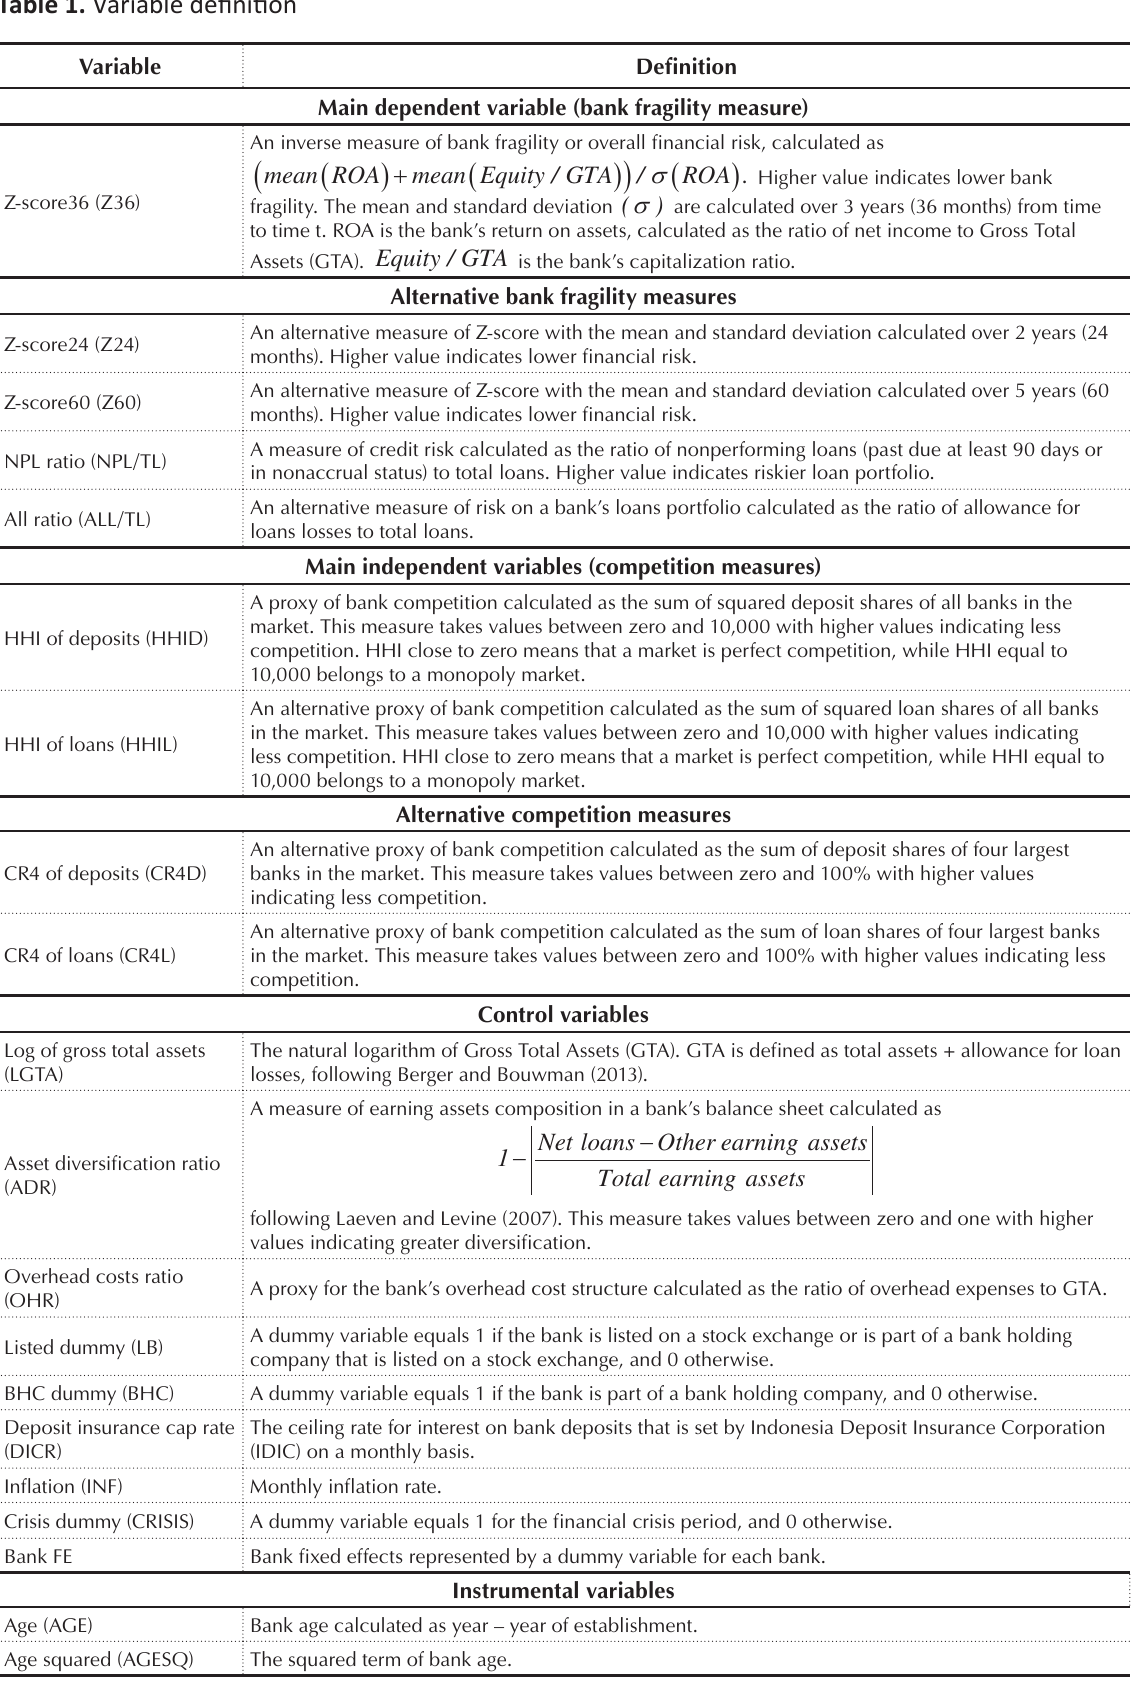
Table 1. (cid:115)(cid:258)(cid:396)(cid:349)(cid:258)(cid:271)(cid:367)(cid:286)(cid:3)(cid:282)(cid:286)(cid:302)(cid:374)(cid:349)(cid:415)(cid:381)(cid:374) Variable Definition Main dependent variable (bank fragility measure) An inverse measure of bank fragility or overall financial risk, calculated as (cid:11) (cid:12) (cid:11) (cid:12) (cid:11) (cid:12) (cid:11) (cid:12) mean ROA mean Equity / GTA / ROA . (cid:86) (cid:14) Higher value indicates lower bank Z-score36 (Z36) fragility. The mean and standard deviation ( ) (cid:86) are calculated over 3 years (36 months) from time to time t. ROA is the bank’s return on assets, calculated as the ratio of net income to Gross Total Assets (GTA). Equity / GTA is the bank’s capitalization ratio. Z-score24